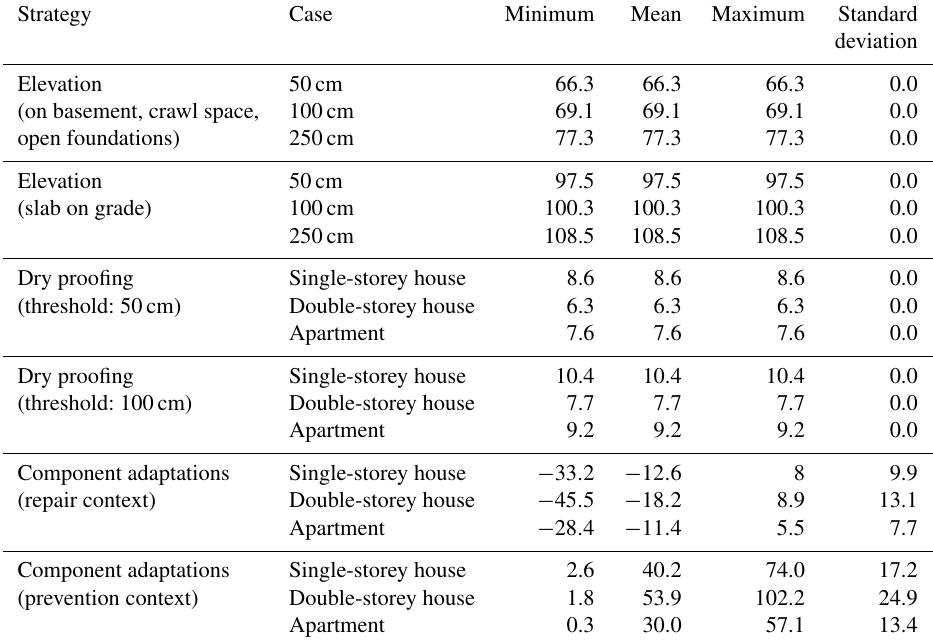
Table 7. Distribution of the cost in thousands of euros across all numerical models of dwellings. Strategy Case